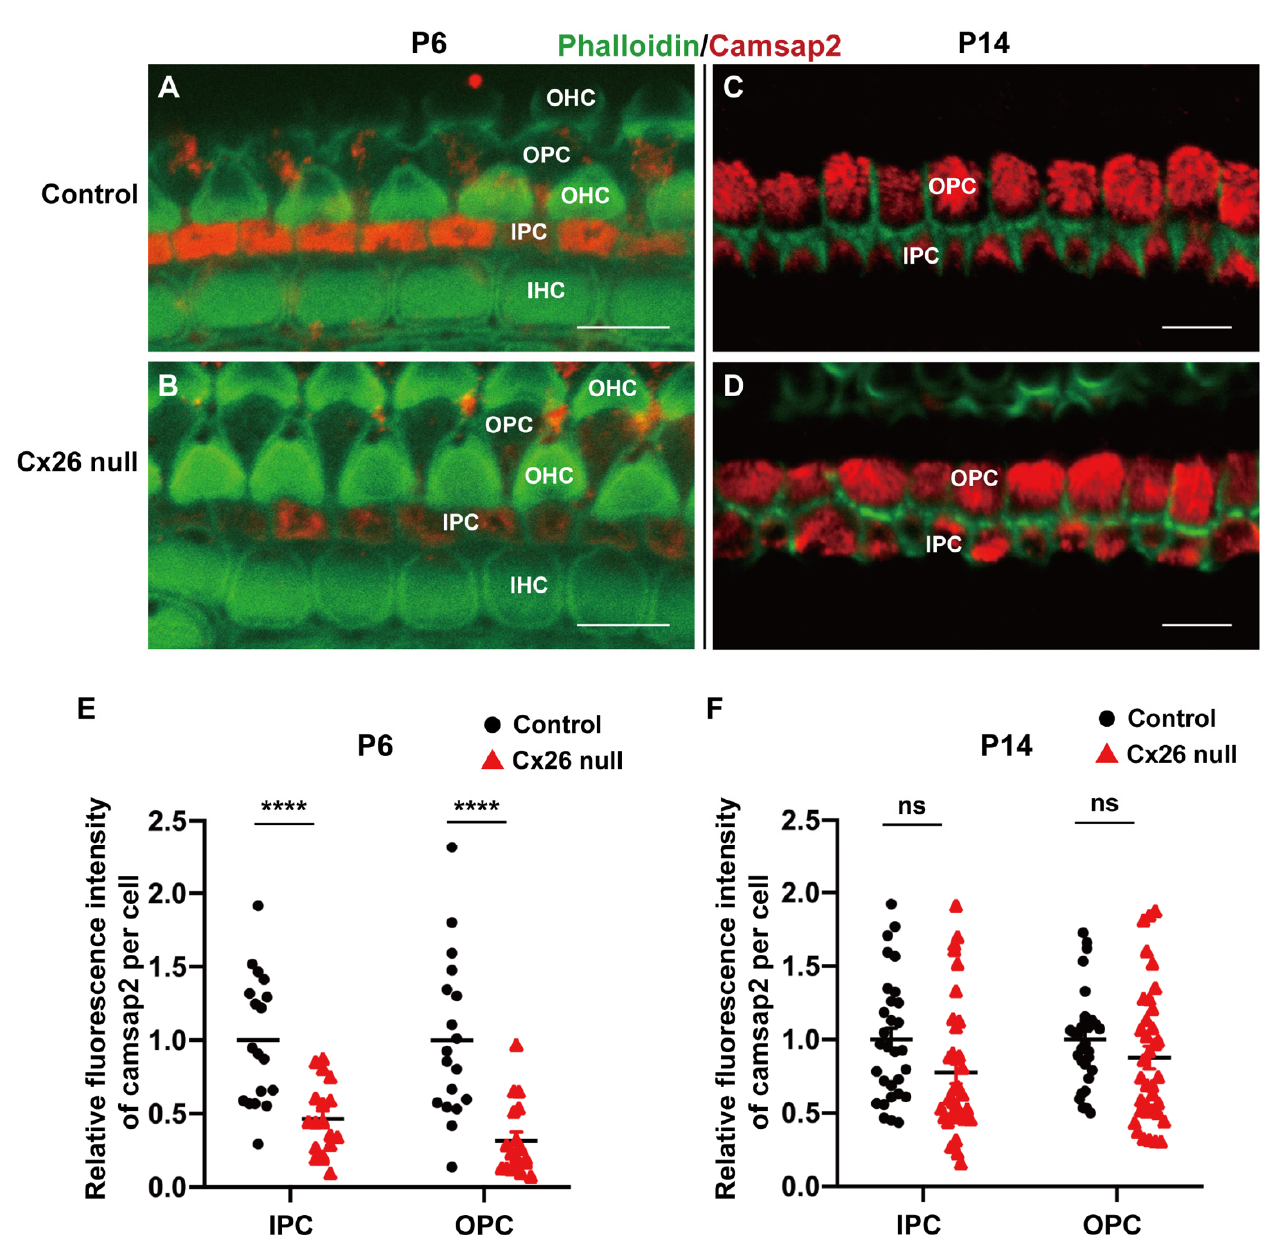
Figure 7. Reduced protein expression level of camsap2 in PCs in Cx26-null group. ( A , B ) The immunofluorescence staining of camsap2 in the apical cochlea at P6. ( C , D ) The immunofluorescence staining of camsap2 in the apical cochlea at P14. ( E ) Quantification of immunolabeling for camsap2 in IPCs and OPCs from the control and Cx26-null groups (18 IPCs and 18 OPCs from 3 mice in each group) at P6. The assessed levels are displayed in plot ( A , B ). The relative fluorescence intensity of camsap2: 1.00 ± 0.10 (control) vs. 0.46 ± 0.06 (Cx26 null) in IPCs, 1.00 ± 0.13 (control) vs. 0.32 ± 0.06 (Cx26 null) in OPCs—data are expressed as mean with SEM, **** p < 0.0001. ( F ) Quantification of immunolabeling for camsap2 in IPCs and OPCs from the control and Cx26-null groups (30~36 IPCs and 30~36 OPCs from 5~6 mice in each group) at P14. The assessed levels are displayed in plot ( C , D ). The relative fluorescence intensity of camsap2: 1.00 ± 0.08 (control) vs. 0.77 ± 0.08 (Cx26 null) in IPCs, 1.00 ± 0.06 (control) vs. 0.88 ± 0.08 (Cx26 null) in OPCs—data are expressed as mean with SEM, ns: no significant difference; P: postnatal, IHC: inner hair cell, OHC: outer hair cell, IPC: inner pillar cell, OPC: outer pillar cell. Bars: about 10 µ m ( A – D